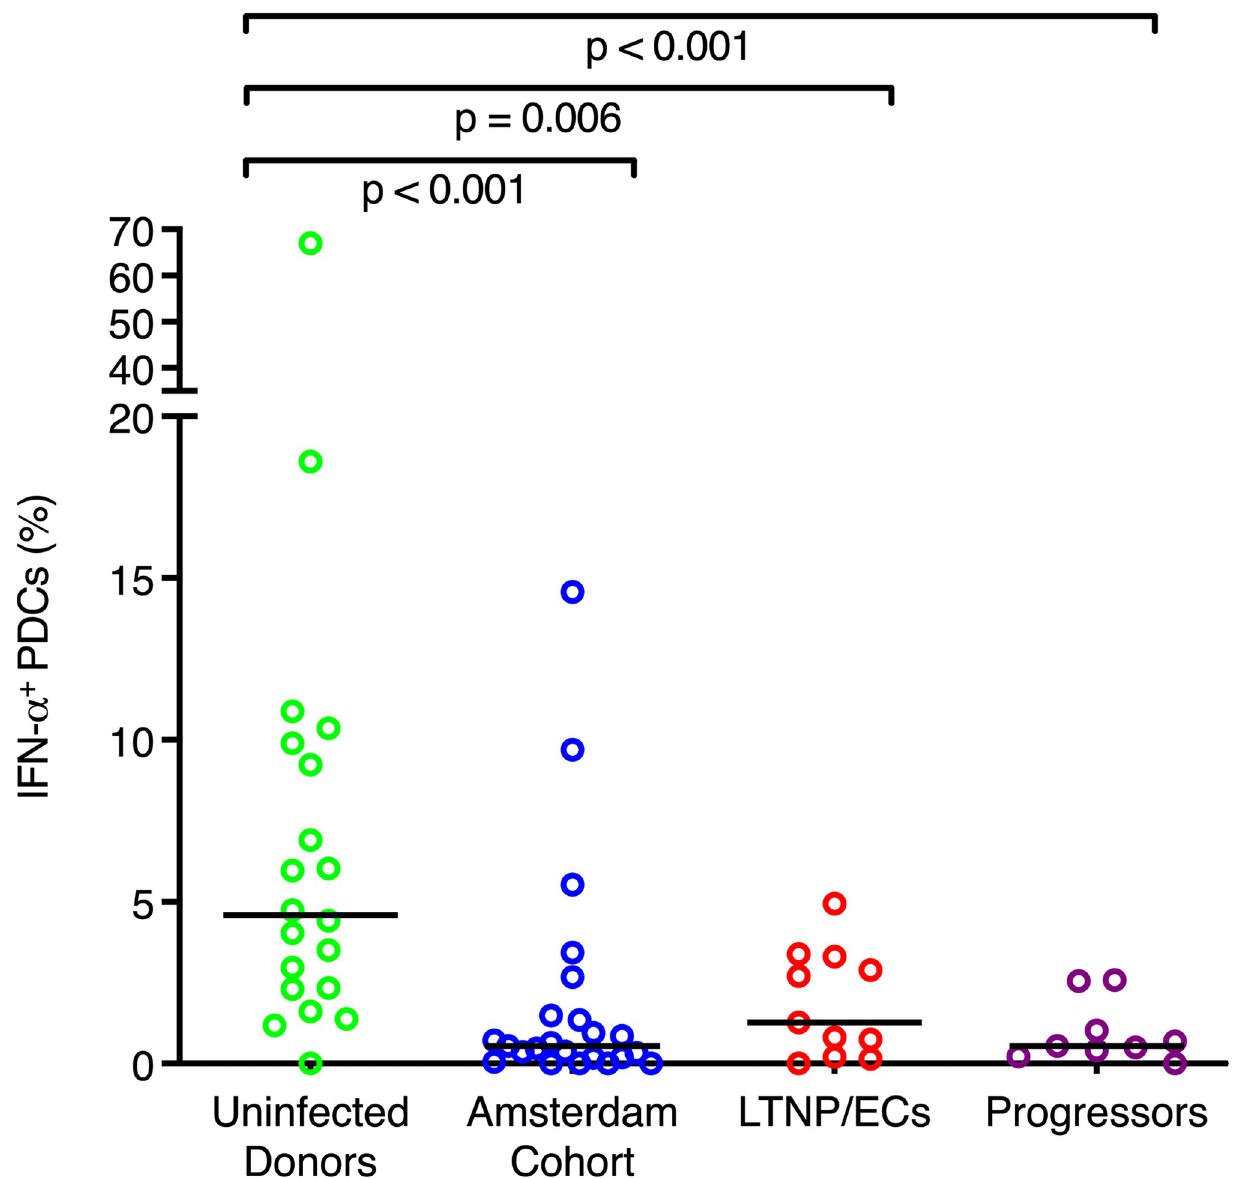
Fig 1. IFN- α production by PDCs stimulated with HIV-1 ADA in four cohorts. Percentage of PDCs from four different cohorts that stained positive for IFN- α after stimulation with HIV-1 ADA : uninfected donors, donors from the Amsterdam Cohort Studies sampled prior to HIV-1 infection, LTNP/ECs, and HIV-infected progressors. Horizontal lines indicate median values. P values were calculated with the Wilcoxon signed-rank test. Only p values for comparisons between uninfected donors and the other cohorts are